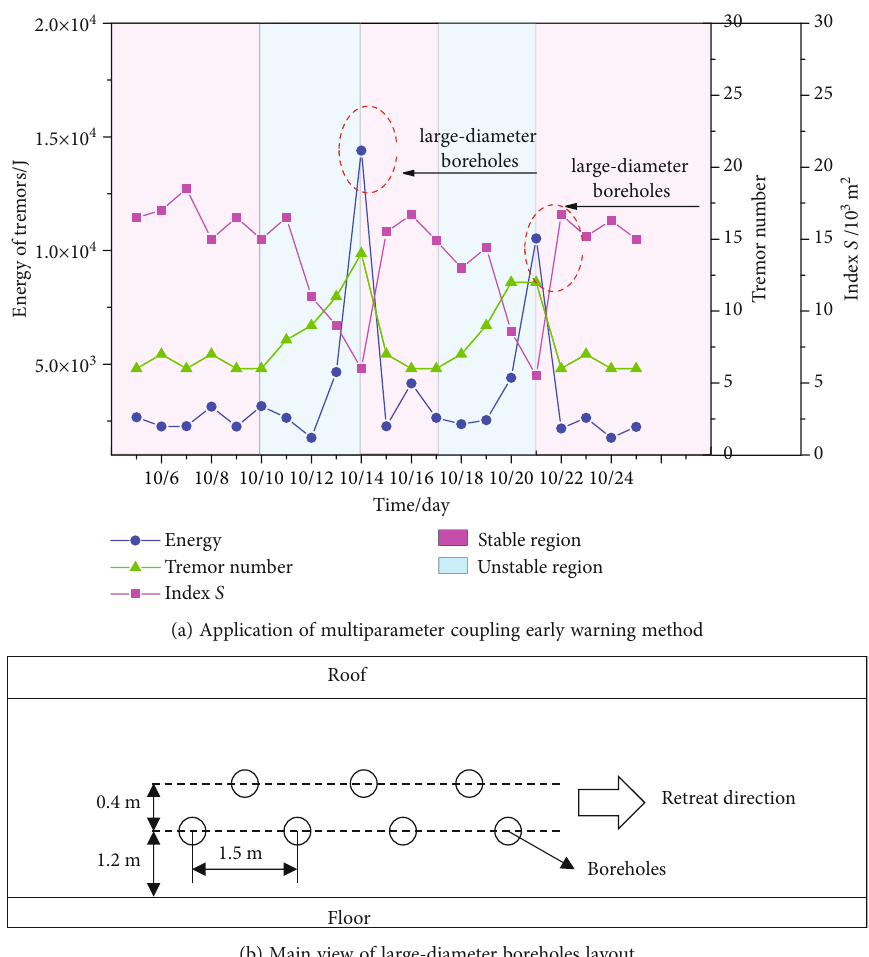
Figure 9: Application of multiparameter coupling monitoring from Oct 5 to